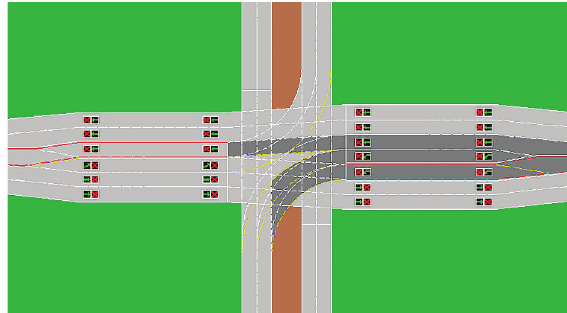
Fig. 8. The morning arrangement (source: own elaboration)